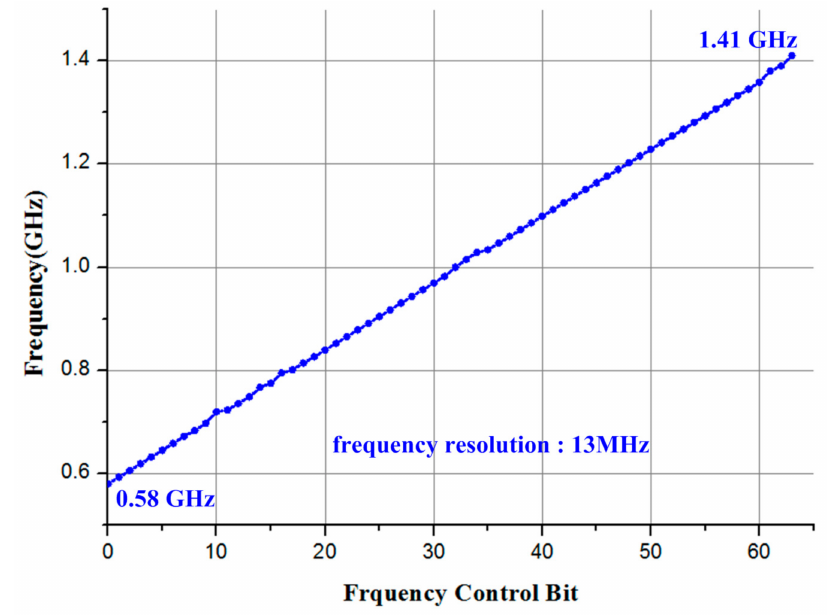
Figure 11. Free-running frequency range of Ring Oscillator.